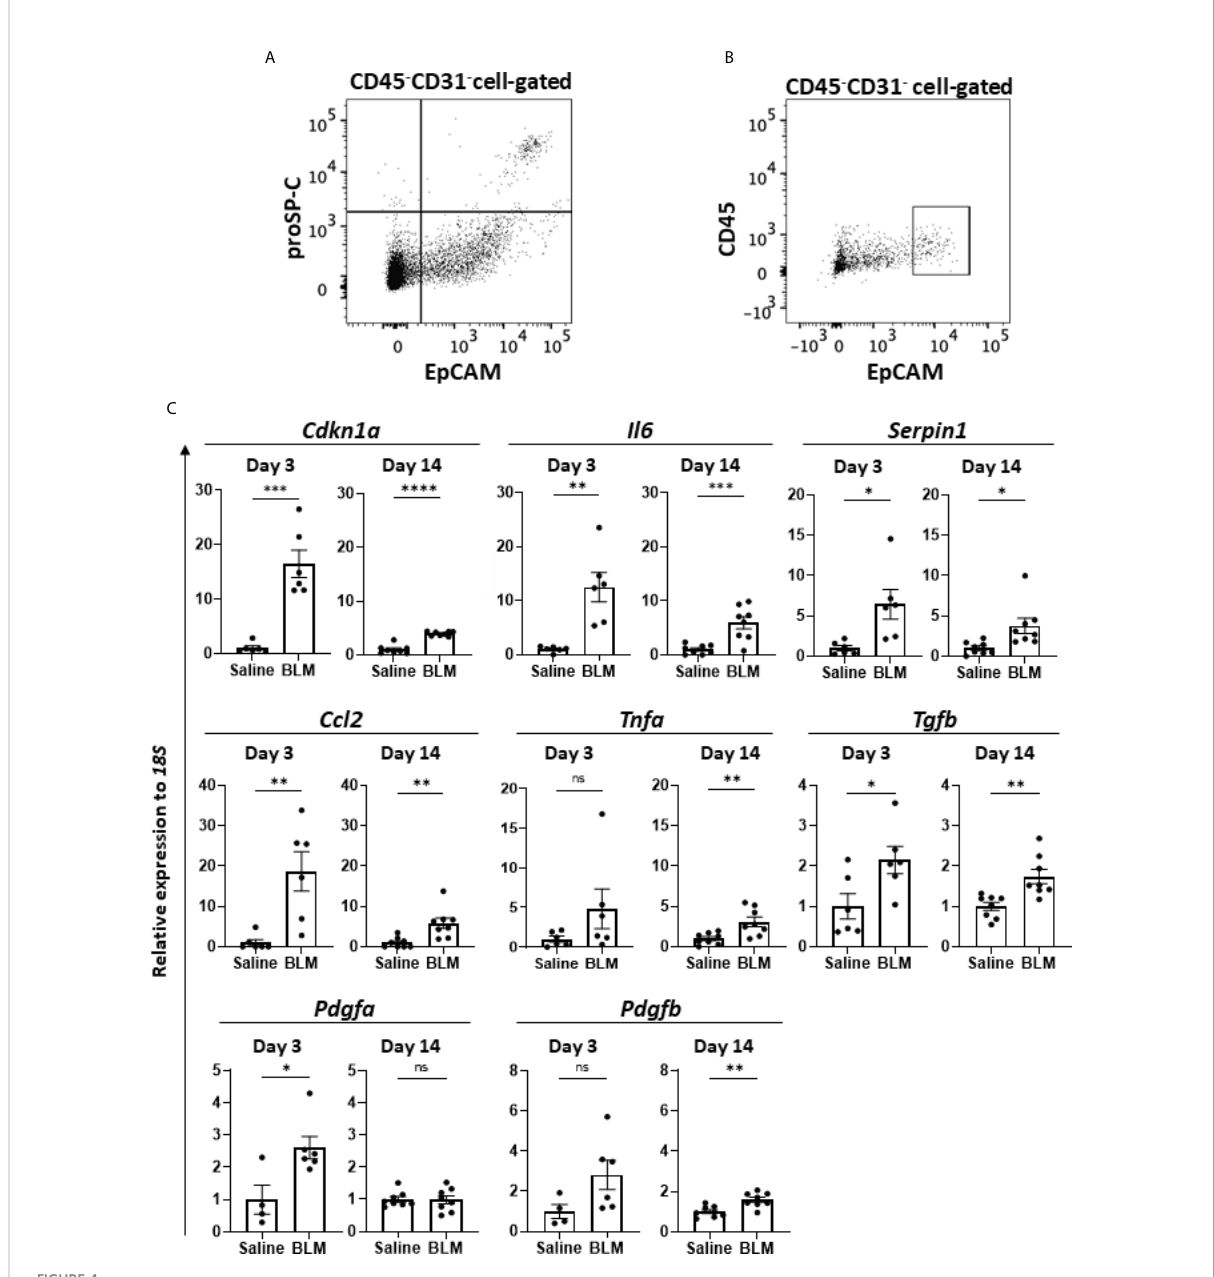
FIGURE 4 SASP-acquired AEC2 express multiple in fl ammatory mediators in BLM-ILD lungs. A cell suspension was obtained from the lungs of mice 14 days after the instillation of BLM and stained with fl uorochrome-conjugated antibodies for a fl ow cytometric analysis. (A) After surface staining with monoclonal antibodies (mAbs) for CD31, CD45, and EpCAM, intracellular staining with an anti-proSP-C polyclonal antibody and Alexa-Fluor 555-conjugated secondary antibody was performed. (B) Gating of the CD45-CD31-EpCAMhi cell population sorted as AEC2. (C) Relative expression of the indicated SASP-related genes in sorted CD45-CD31-EpCAMhi cells from BLM-ILD lungs 3 and 14 days after the instillation of BLM. n = 6 on day 3; n = 8 on day 14. Data are presented as the mean ± SEM. Statistics show p-values from the unpaired t-test. ns, not signi fi cant. *p < 0.05; **p < 0.01; ***p < 0.001; ****p <